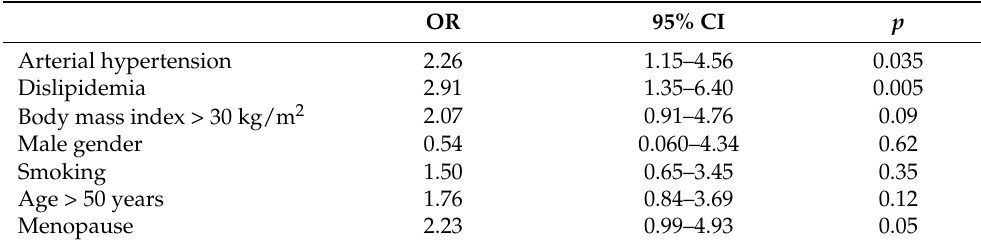
Table 3. Factors associated with the development of carotid atherosclerotic plaques in RA patients with low cardiovascular risk.